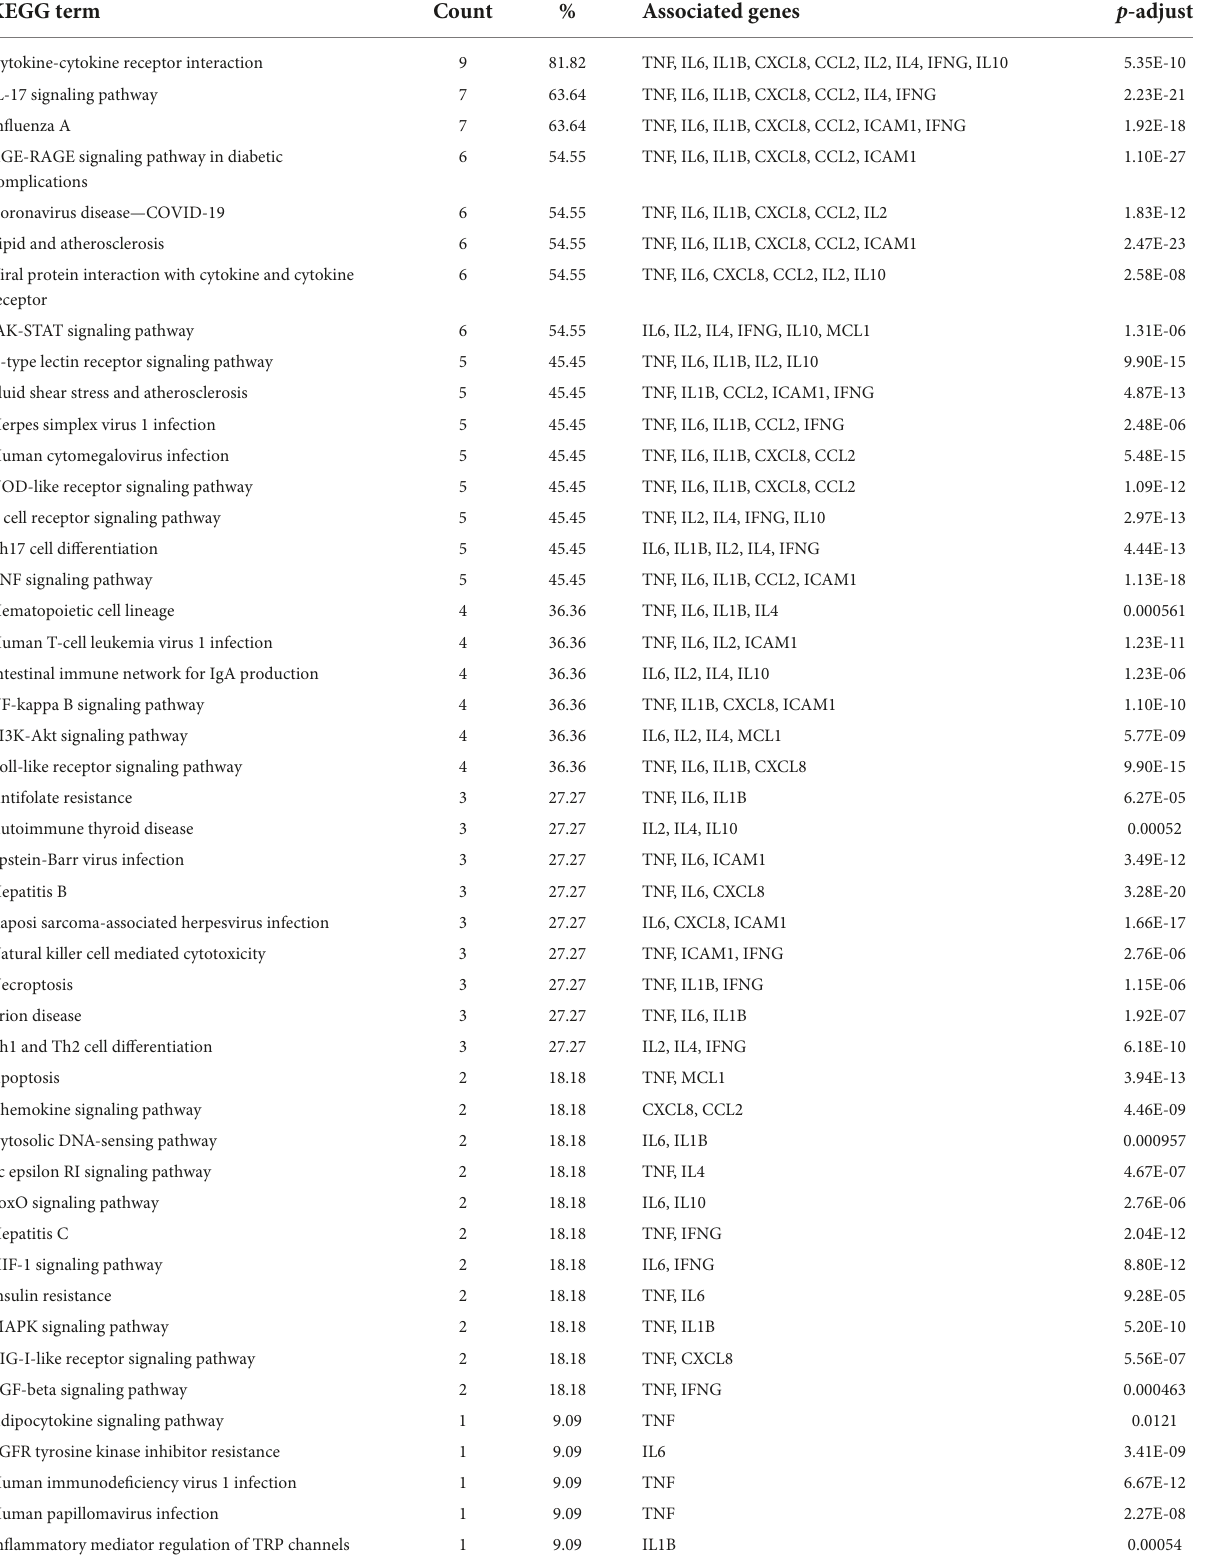
TABLE 4 Four CPMs hub genes and their associated